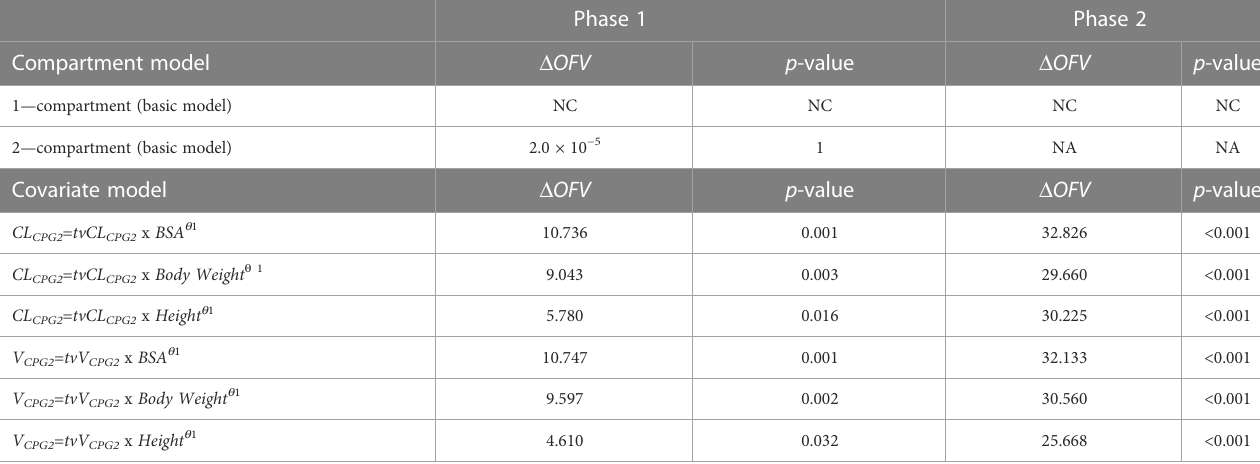
TABLE 3 Covariate screening of CPG2 in the phase 1 and 2